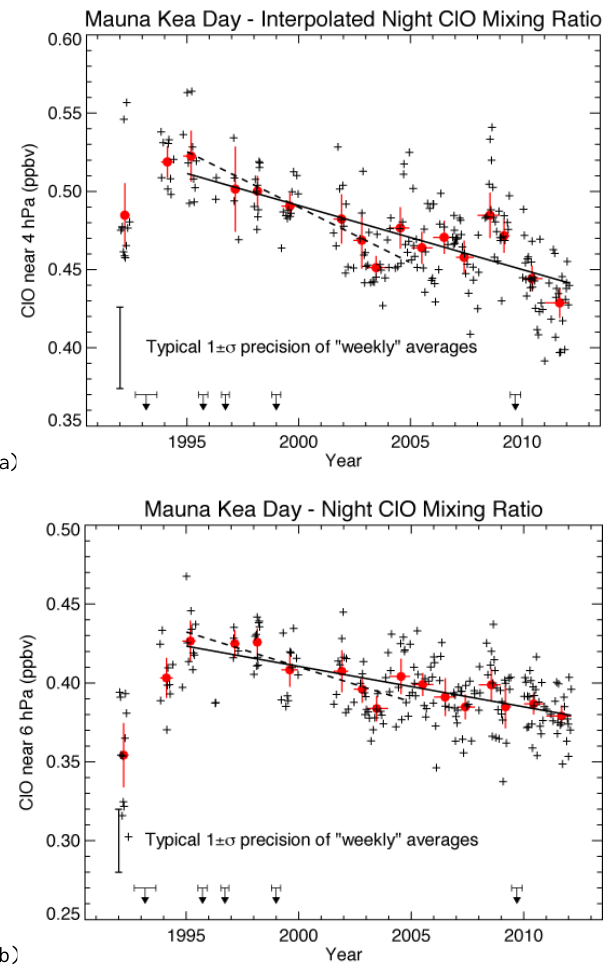
Fig. 7. Time series of peak ClO mixing ratios over Mauna Kea, 1992–2012. Data in (a) are derived from daytime spectra, while for data in (b) simple day–night spectra are used. The dashed lines show regression fits to data from 1995 to 2004, while solid lines are re- gression for